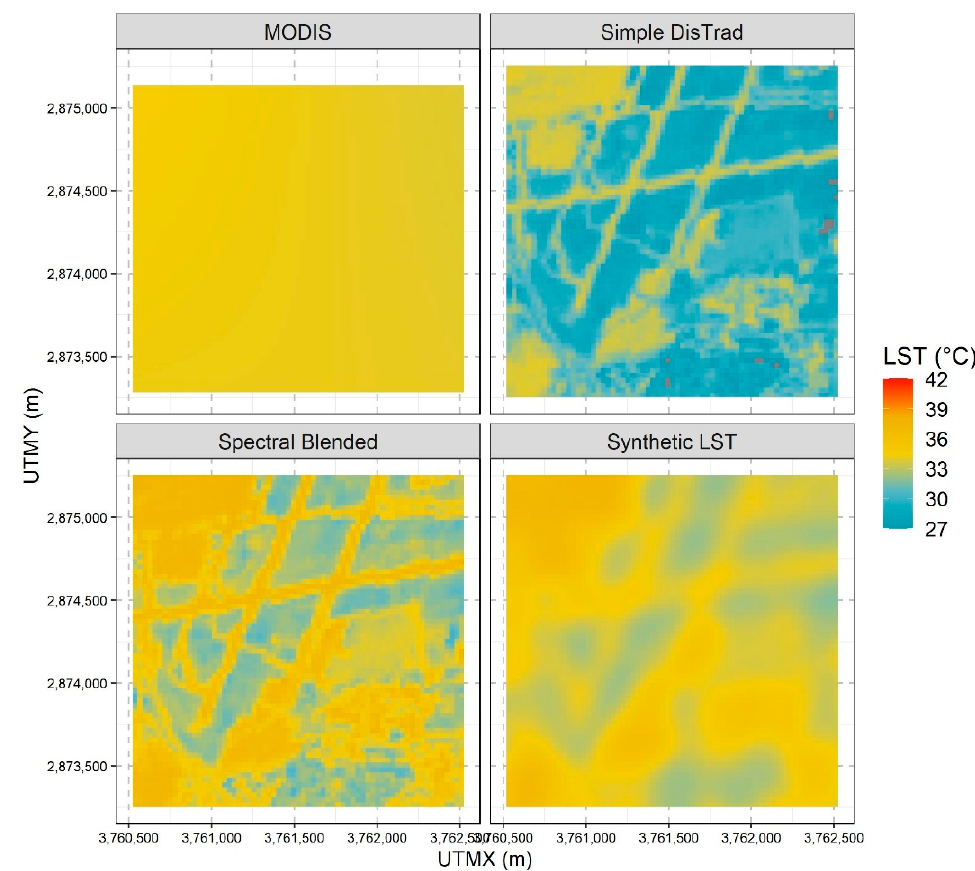
Figure 10. Visual summary the processing steps to create the synthetic LST and comparison to the LANDSAT LST using a small section of the images. UTMX and UTMY are the x (EW) and y (NS) coordinates in map projection using Universal Transverse Mercator (UTM) coordinate system. Table 3. Evolution of the mean squared error (MSE), root mean squared error (RMSE) and mean absolute error (MAE) during the processing steps. The “adjusted” indicators are used to remove the bias caused by differences in time of day.